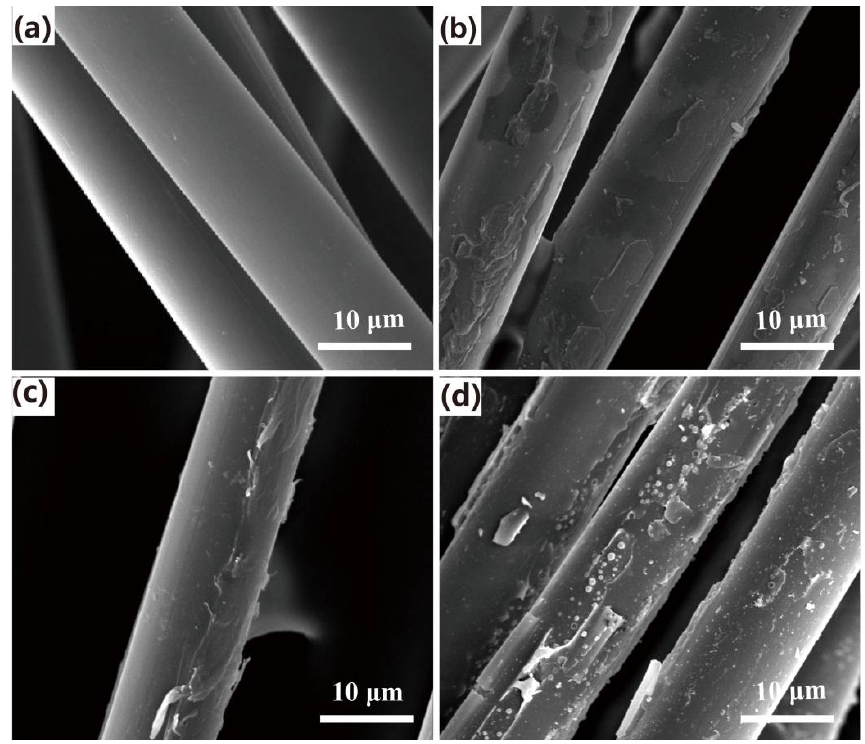
Figure 5. SEM pictures of CAF: ( a ) virgin, ( b ) dopamine-treated, ( c ) vinyl triethoxysilane-treated, and ( d ) dopamine and vinyl triethoxysilane-treated. and ( d ) dopamine and vinyl